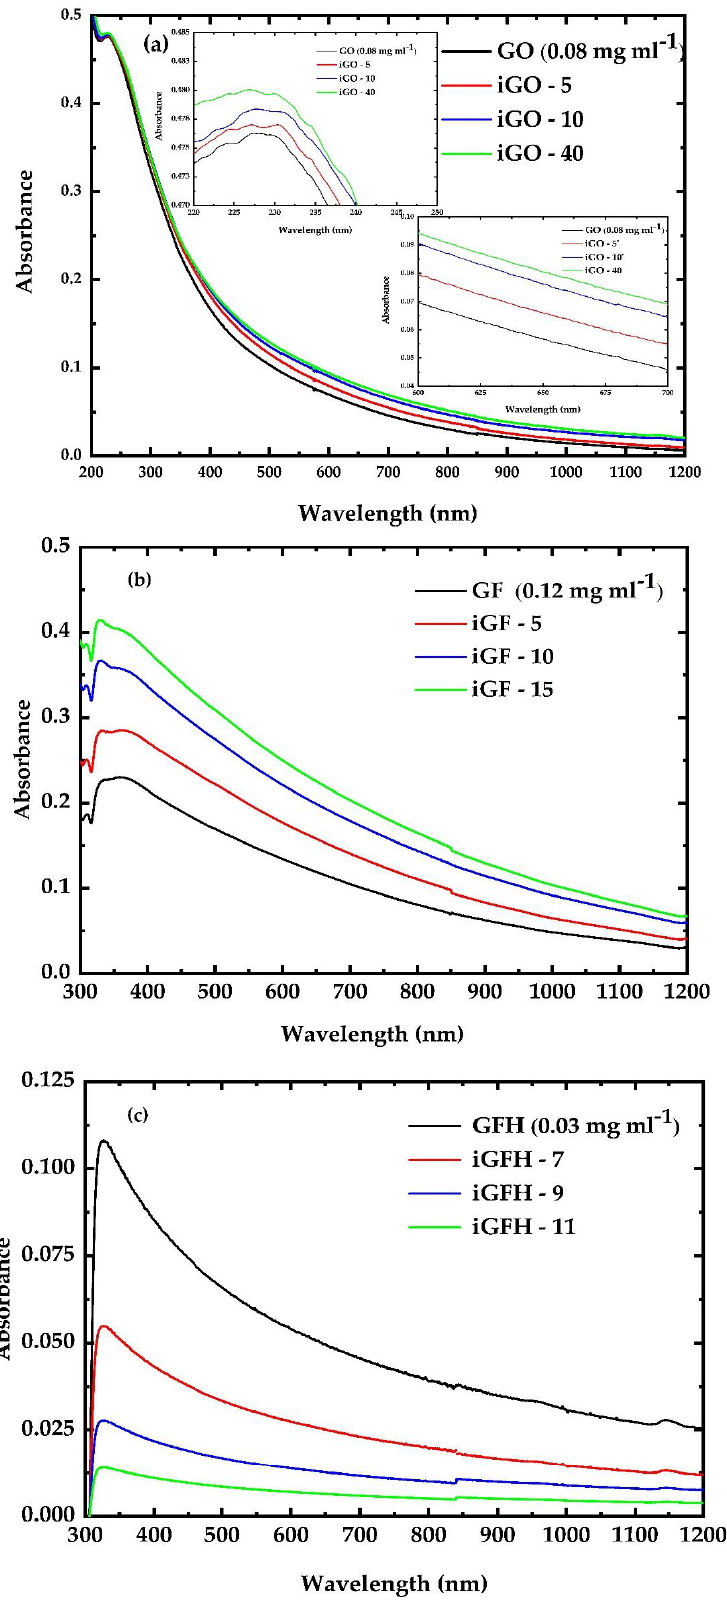
Figure 2. Evolution of the UV – Vis – NIR absorption spectra of non-irradiated and irradiated ( a ) GO, ( b ) GF and ( c ) GFH dispersions under UV irradiation. Then, the GFH dispersions were UV-irradiated for three 5 min irradiation cycles us- ing a fluence of 5 mJ cm −2 . As shown in Figure 2c, the GFH dispersion absorption spectrum is dominated by a strong absorption band located at ~330 nm, while it is structureless towards longer wavelengths. Interestingly, in contrast to the behavior observed for the corresponding characteristic GF absorption band, an increase in the UV exposure time of the GFH dispersion resulted in a significant decrease in the GFH absorption band, initially leading to its gradual attenuation and its total extinction for irradiation durations greater than 10 min, suggesting a drastic change in the conjugation. This observation suggests the lowering of the energy bandgap. More specifically, while the energy bandgap of non-ir- radiated GFH is estimated to be ~2.7 eV the bandgap of the iGFH-11 was estimated to be ~2.5 eV. Moreover, it has been shown that the degree of fluorination and the confor- mations of the F atoms on the graphenic sheet can greatly influence the bandgap of GFH [45]. Therefore, as the irradiation time increases the degree of fluorination decreases, lead- ing to the lowering of the bandgap value. Finally, pristine graphene (G) dispersions in DMF were irradiated for various irradi- ation cycles with a fluence of 25 mJ cm −2 . The corresponding UV – VIS – NIR absorption spectra are presented in Figure 3. Although graphene dispersions were irradiated for more than one hour totally, at laser fluences higher than those used for GO, GF and GFH no measurable modifications/changes were observed in their UV – VIS – NIR absorption spectra. This finding most probably indicates that no major conjugation changes in the graphenic sheet have taken place under UV irradiation.